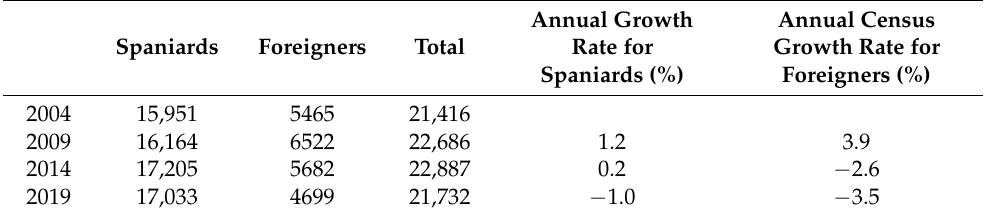
Table 2. Population of Santa Catalina-Canteras. Source: Own elaboration based on the Continuous Population Register, INE (National Statistics Institute).